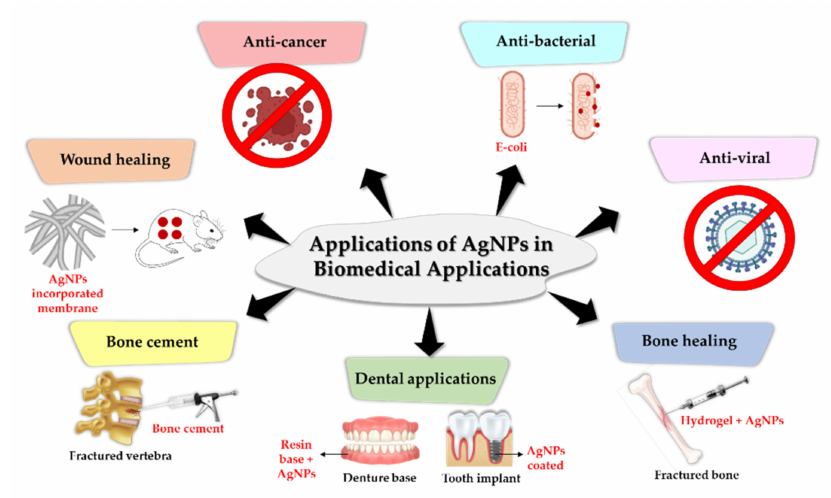
Figure 9. Applications of AgNPs in Biomedical Applications.